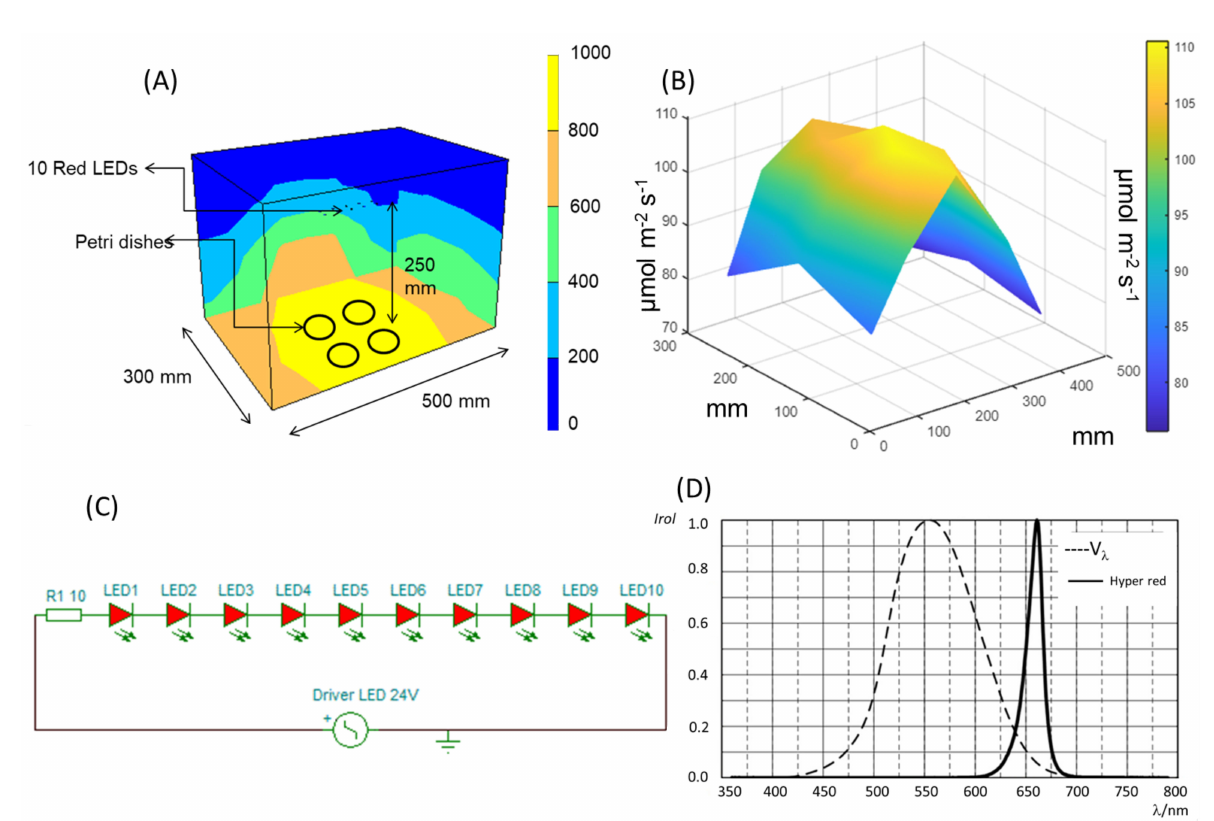
Figure 7. Presentation of the ( A ) dimensions, main components, operation workflow, and ( B ) spatial distribution of the photosynthetically active radiation (PAR, µ mol m − 2 s − 1 ) on the modulable spectrum plant experimental chamber (MSPEC) inner surface for 10-LEDs luminaires, as well as ( C ) the 10-LED circuit diagram used in the experiment. ( D ) Osram GH CSSRM5.24 Relative Spectral Emission (Irel = f ( λ ); IF = 700 mA; TJ = 25 ◦